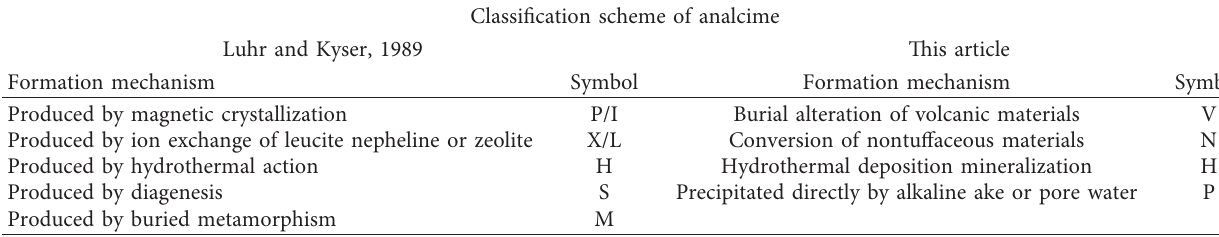
Table 1: Classification scheme of analcime.